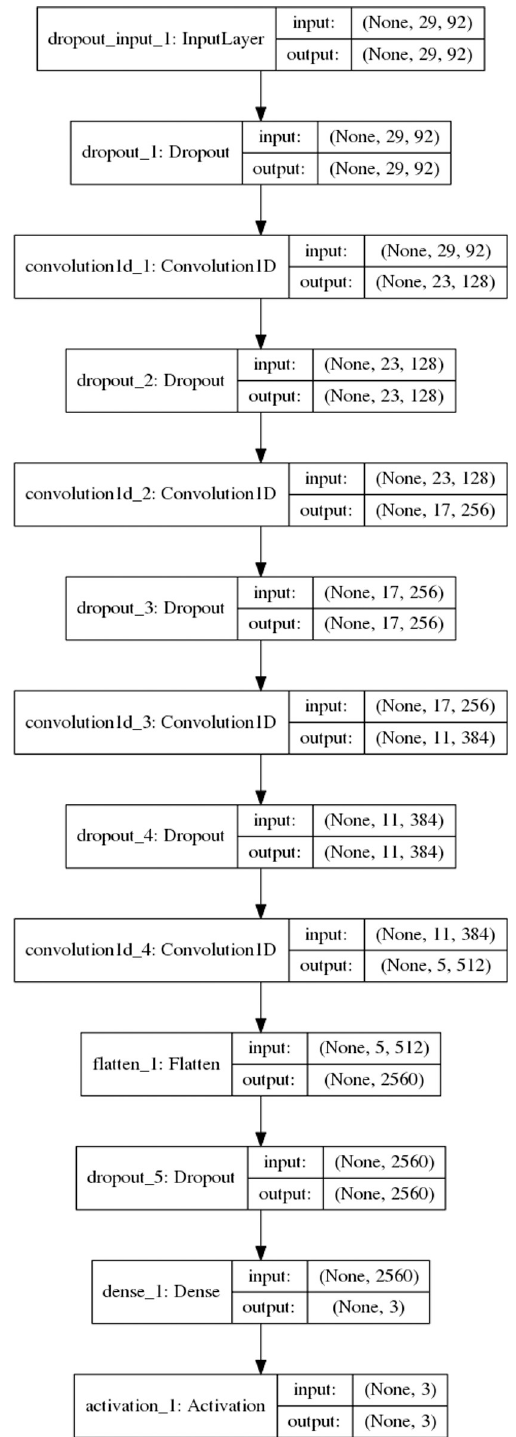
Fig 2. Architecture of SecNet . SecNet is a traditional CNN with an input layer, 4 hidden convolutional layers, and a dense layer with dropout regularization layers in between. The input layer reads a 29 x 92 matrix representing a sequence window of 29 amino acids centered on the one subject to prediction and 92 input features for all 29 positions. 92 features = one-hot encoding of 22 amino-acid types + 2 rounds x 20 PSI-BLAST profile values + 30 HMM alignment parameters. Each box encloses a linear dimensionality and number of features (2 nd and 3 rd values